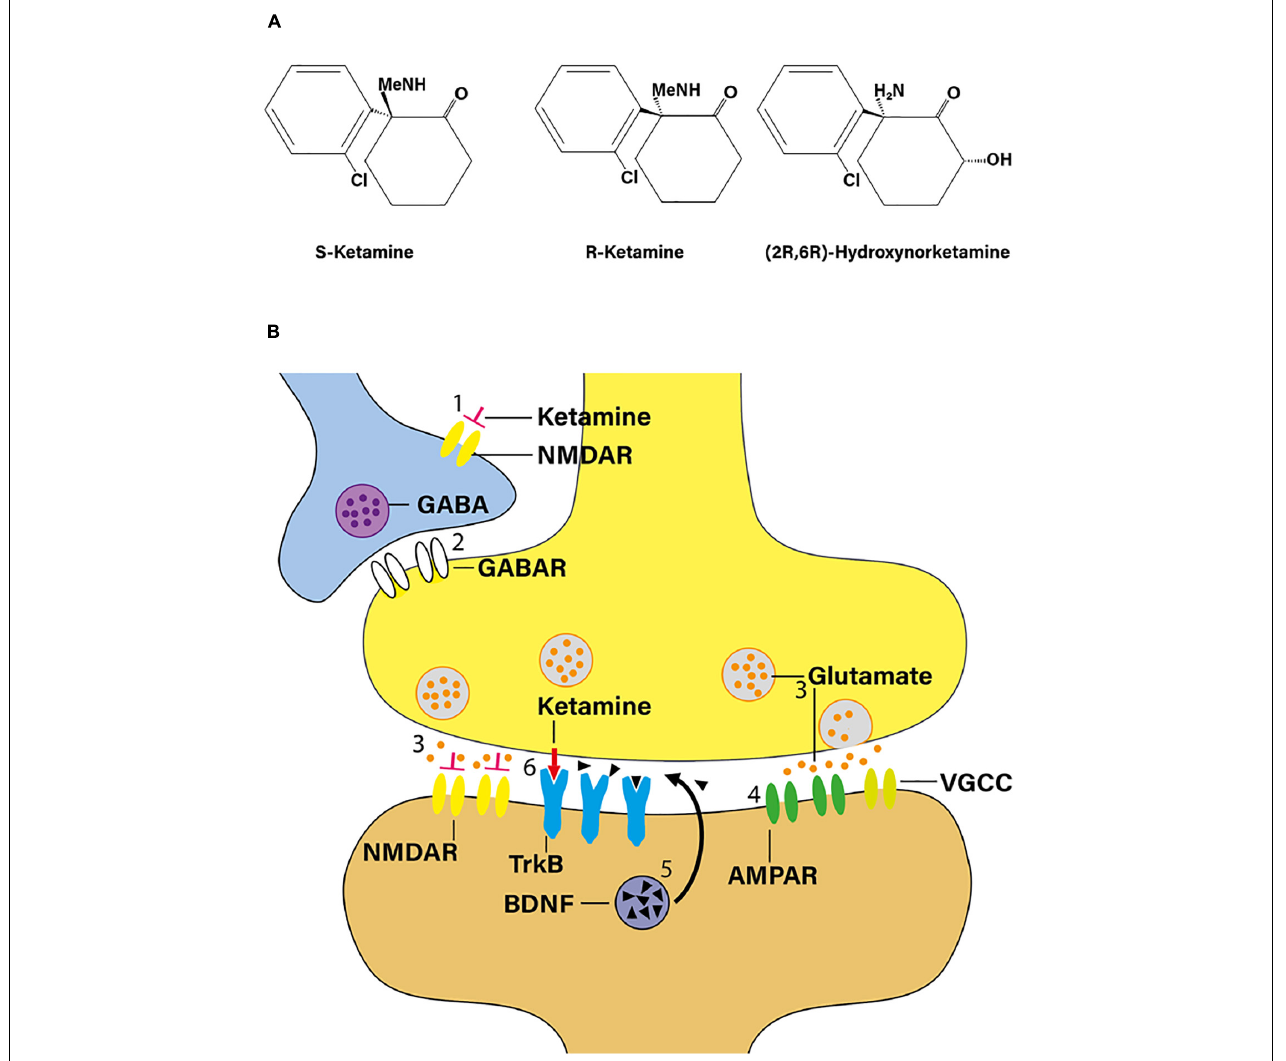
FIGURE 1 | Ketamine as a novel antidepressant. (A) Structural formula of S-ketamine, R-ketamine, and R-ketamine metabolite 2R,6R-hydroxynorketamine (adapted from Zanos et al., 2016). Me, methyl moiety. (B) According to the “disinhibition hypothesis” of ketamine action, NMDA receptor blockade by ketamine may increase glutamatergic outflow. When administered in a subanesthetic dose, ketamine blocks NMDA receptors on γ -aminobutyric acid (GABA) interneurons (1), thereby reducing GABA release (2) on principal neurons, and, in turn, increasing presynaptic release of glutamate (3). Preferential activation of postsynaptic α -amino-3-hydroxy-5-methyl-4-isoxazole-propionic acid receptors (AMPAR) in mood-regulating synapses (4) is believed to play a critical role in mediating ketamine’s rapid antidepressant response, triggering downstream changes such as inducing BDNF signaling (5). In addition, ketamine may also interact with the TrkB receptor directly (red arrow; 6). TrkB, tropomyosin receptor kinase B; VGCC, voltage-gated calcium channel (adapted from Shinohara et al.,